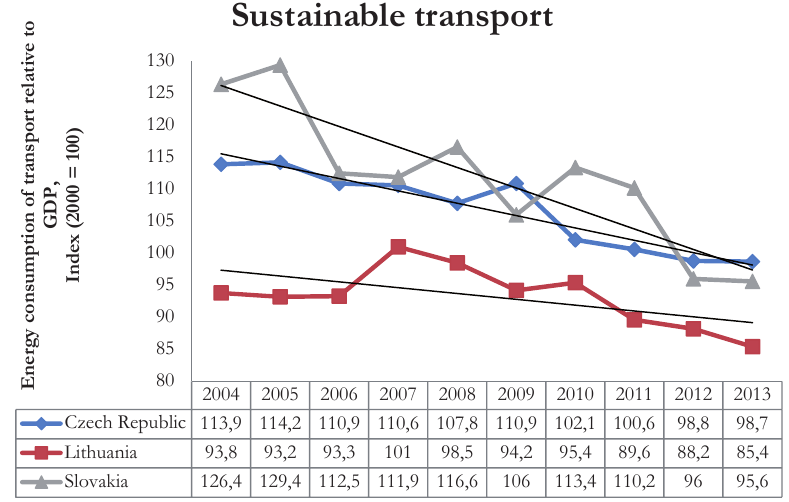
Fig. 4 – Sustainable transport. Source: Eurostat. (2015d). Energy consumption of transport relative to GDP. Retrieved February 22, 2016, from